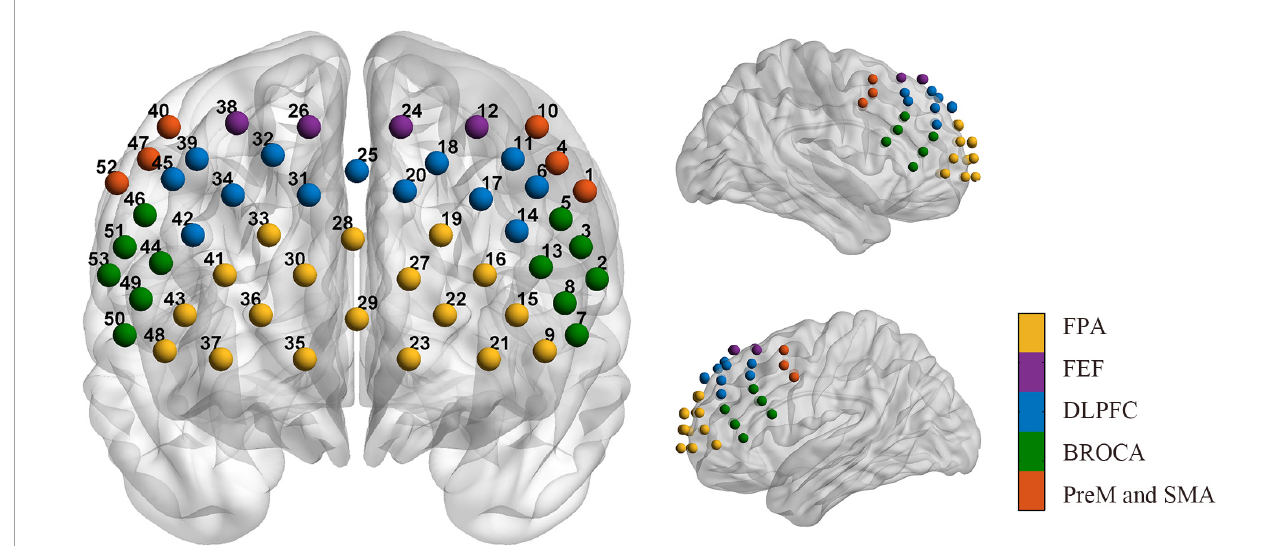
FIGURE1 Arrangement of the 53 channels covering the frontal lobe. Including the PreM and SMA (red, Premotor, and supplementary motor area), FEF (purple, frontal eye fields), BROCA (green, Broca’s area), FPA (yellow, frontopolar area), and DLPFC (blue, dorsolateral prefrontal cortex).